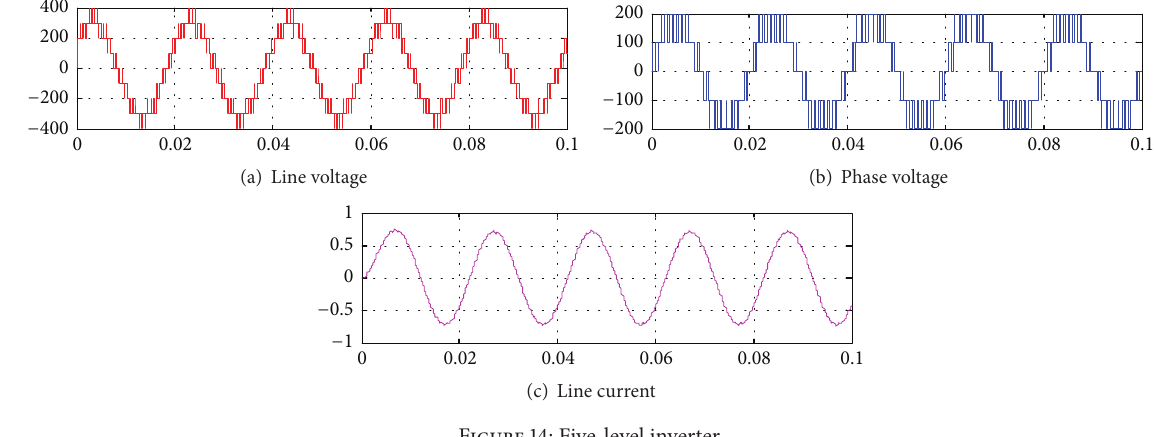
Figure 14: Five-level